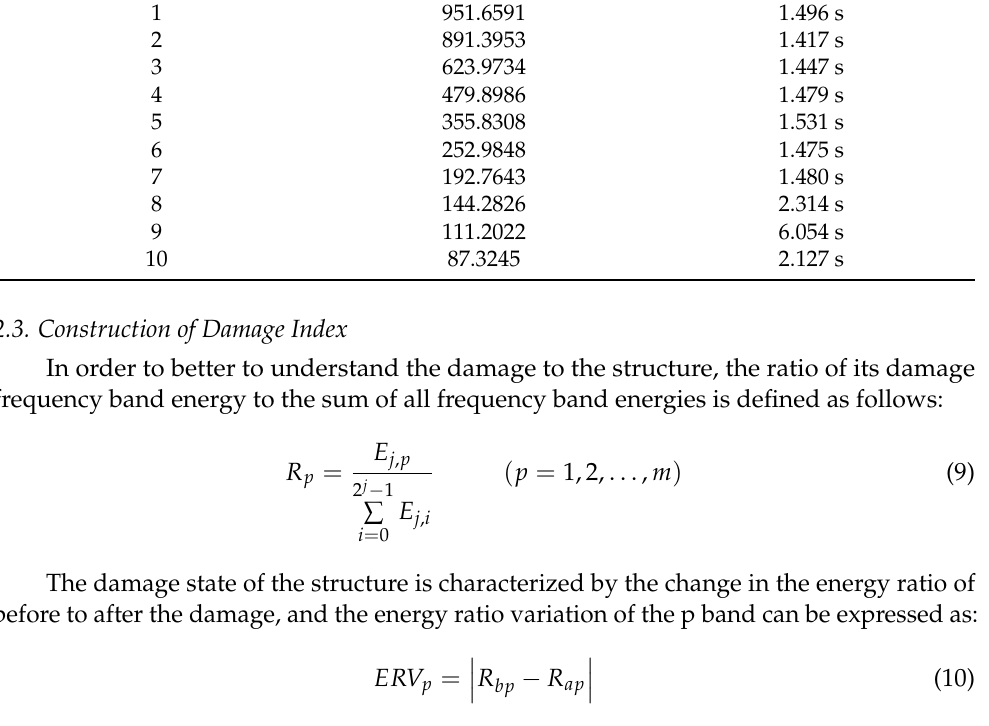
Table 2. Cost function values and computational time of db15 wavelet decomposition 10 layers. Decomposition